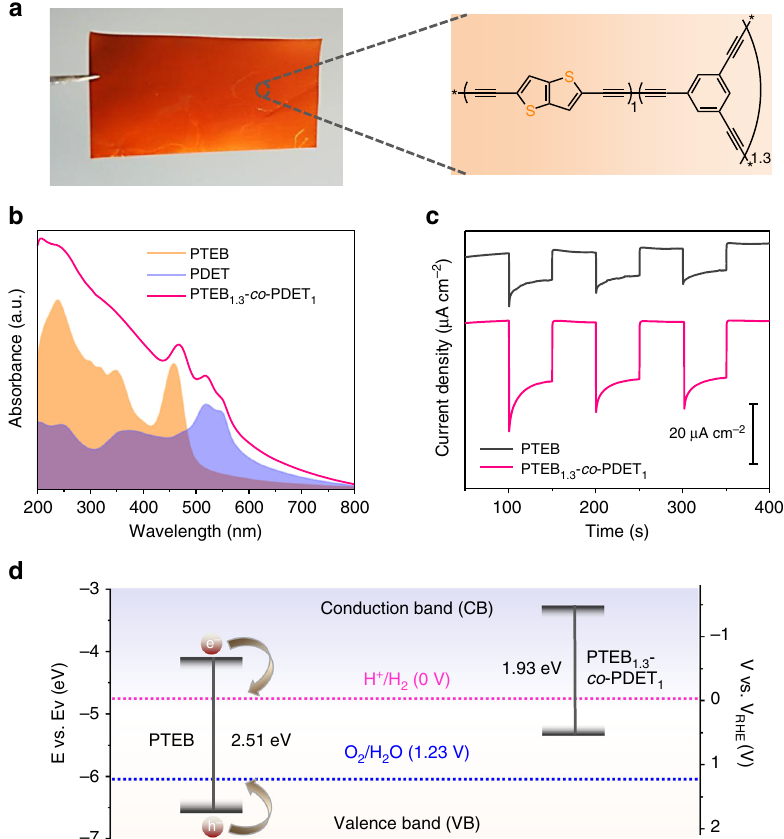
Fig. 5 PTEB incorporated with poly[2,5-diethynylthieno[3,2-b]thiophene] (PDET) as photocathode. a Photograph of PTEB 1.3 - co -PDET 1 grown on a Cu surface (left) and its chemical structure (right). b UV-vis absorption spectra of PTEB, PDET and PTEB 1.3 - co -PDET 1 , respectively. c Transient photocurrent density vs. time at a bias of 0 V vs. RHE under intermittent irradiation for PTEB 1.3 - co -PDET 1 (red curve) and pristine PTEB (black curve). d Band structure diagram of the PTEB 1.3 - co -PDET 1 compared with PTEB. In all panels, the average thickness of the polymer fi lms is ca. 230 cm − 2 at 0 V vs. RHE (i.e., − 0.6 V vs. Ag/AgCl; Fig. 5c). This − 2 at value is comparable to that of the B 13 C 2 (ca. 16 µA cm – Table 1) 50 and even inorganic 2D WSe 2 thin fi lms (ca. 40 µA cm − 2 at 0 V vs. RHE, i.e., − 0.2 V vs. Ag/AgCl) 9 . The PTEB 1.3 - co - PDET 1 has a conduction band minimum of − 1.47 V vs. NHE